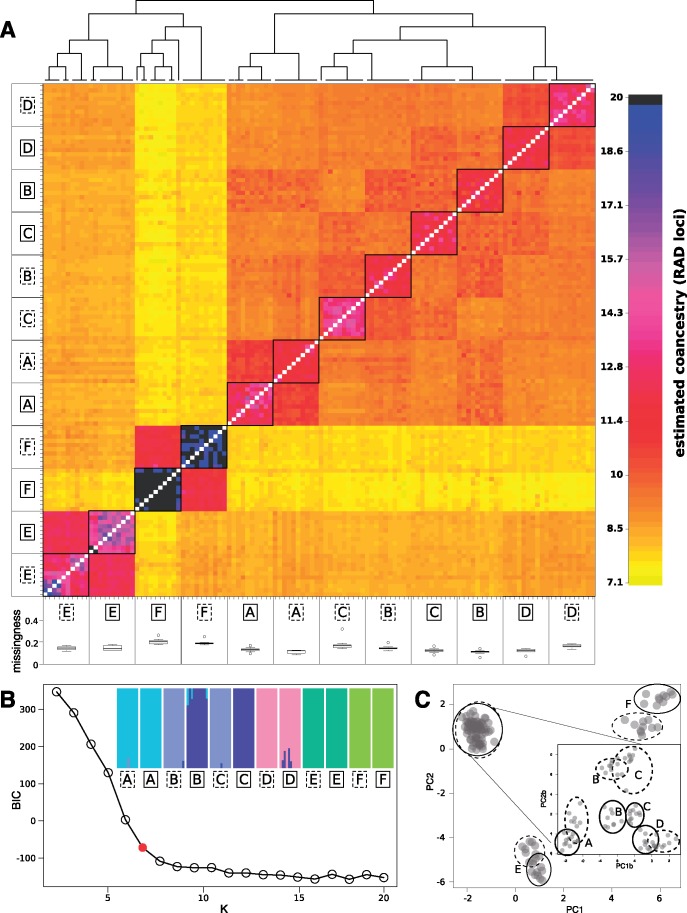
Method comparison: fineRADstructure, fastSTRUCTURE, and adegenet PCA. The analyses include individuals from six localities (A–F) and two sibling species (Heliosperma pusillum: solid line, Heliosperma veselskyi: dashed line). (A) Clustered fineRADstructure coancestry matrix. Individuals within the twelve populations share more coancestry with each other than between populations. Hierarchical structure among and between localities is clearly inferred—populations at localities B and C cluster by species, whereas populations at localities A, D, E, and F cluster by locality. Missingness is shown below each population label, confirming that it does not vary systematically between inferred populations. (B) fastSTRUCTURE results are shown at the suggested model complexity K = 6; the inflection point where the goodness-of-fit curve—BIC estimated for increasing number of K changes its slope. (C) PCA as implemented by the adegenet package. The main plot uses all samples, while the inset shows PCA performed only on individuals from population pairs A–D.